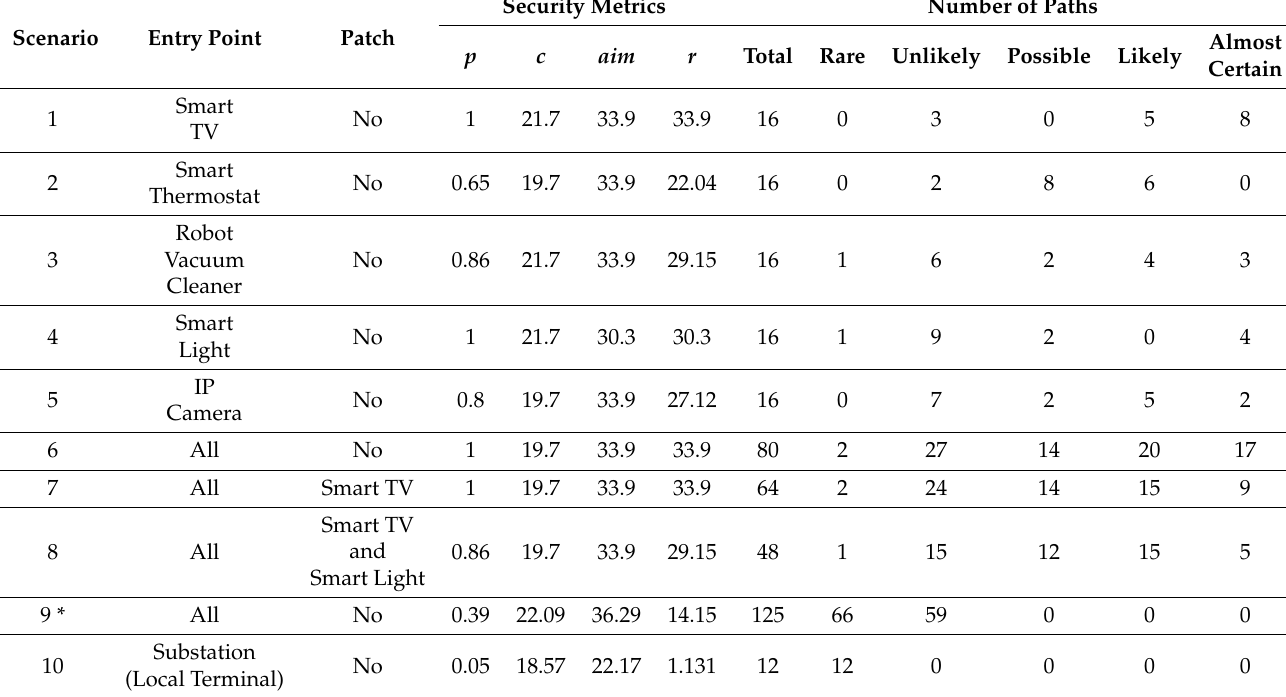
Table 5. Attack analysis